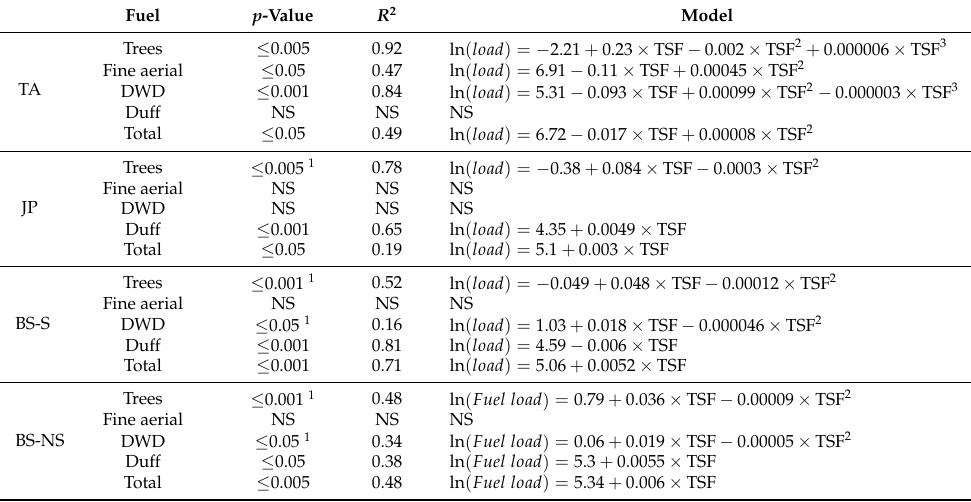
Table 2. p -value, adjusted R 2 and equations extracted from the regression polynomial analysis of tree, fine aerial vegetation (shrubs + herbs), DWD, duff, and total fuel loads with TSF for TA, JP, BS-S, and BS-NS dominated forests. NS stands for a non-significant relationship.